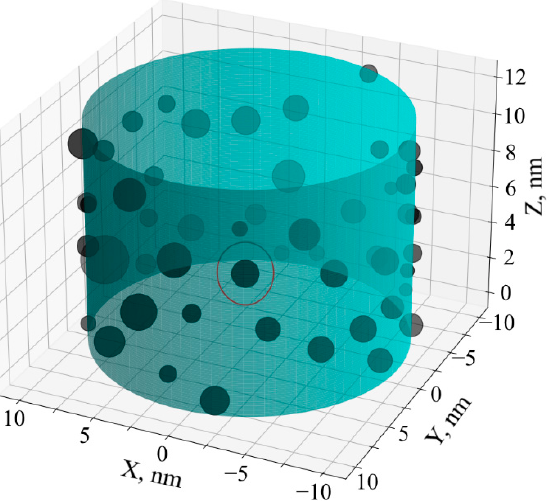
Figure 9. Cylindrical surface corresponding to a CNT region (20 nm in diameter and 12 nm in height) with a random distribution of particles obtained by the simulation (R c = 0.4 nm).